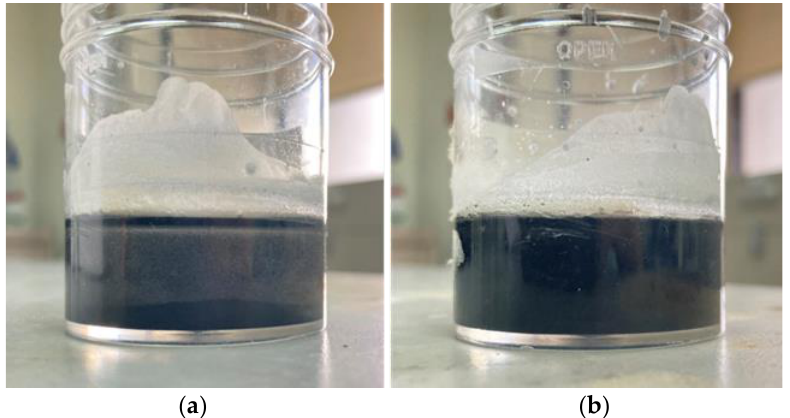
Figure 3. Images showing the dispersion stability of PCM material with ( a ) ACMPs only and with ( b ) ACMPs + PEG after 2nd cycle. ( b ) ACMPs + PEG after 2nd